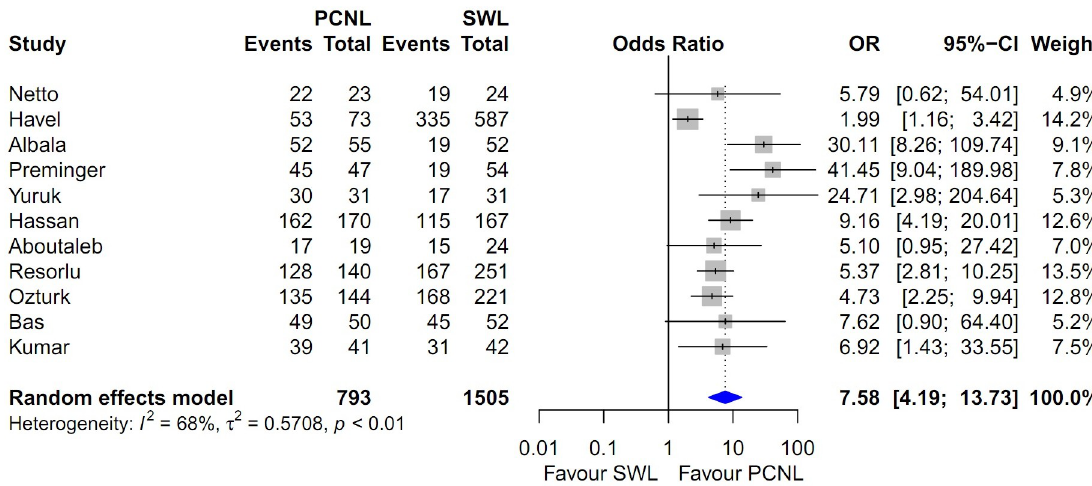
Fig 4. Pairwise meta-analysis of success rate in PCNL and SWL. Results show that the stone-free rate of PCNL was superior to SWL (OR 7.71; 95% CI 4.08–14.57; P < 0.001).